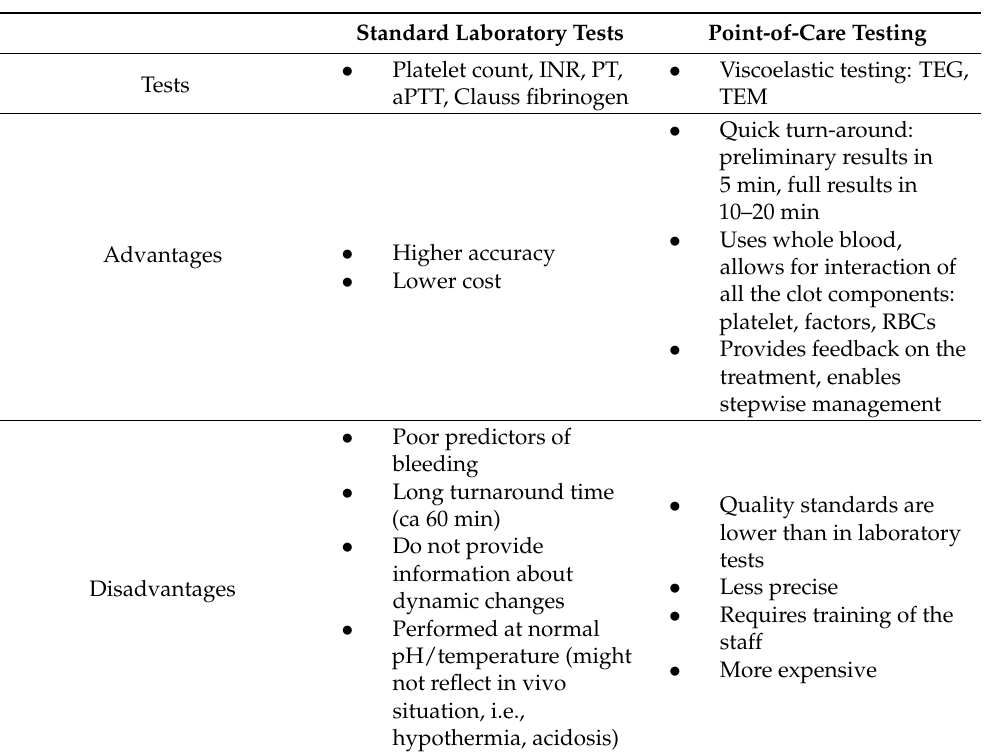
Table 2. Comparison of standard laboratory tests vs. point-of-care testing